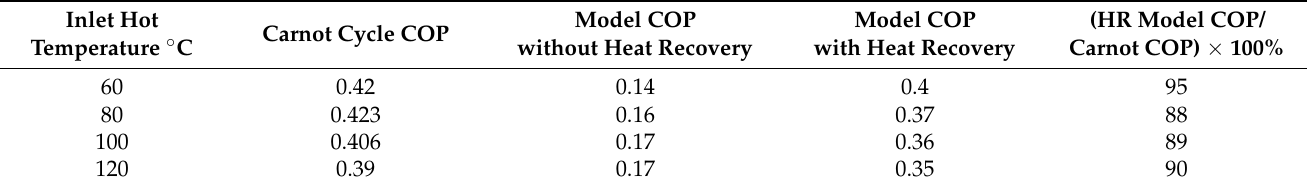
Table 2. Carnot cycle COP at different heating source input temperature.